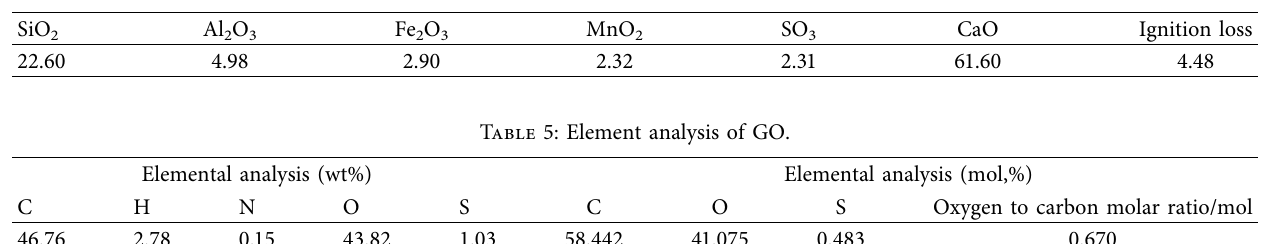
Table 4: Chemical compositions of ordinary Portland cement (wt. %).